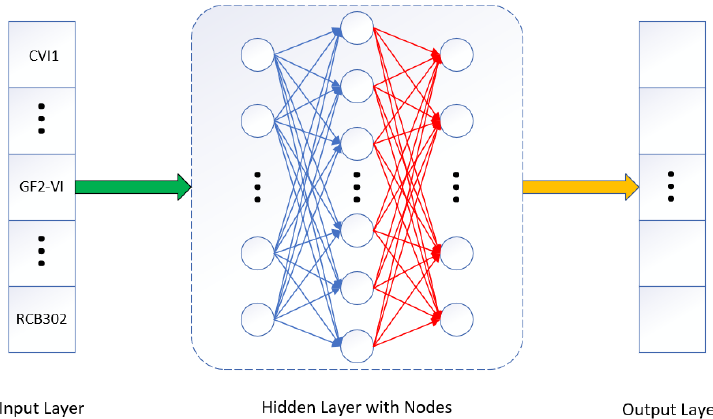
Figure 3. Schematic diagram of the BP artificial neural network used in this study.